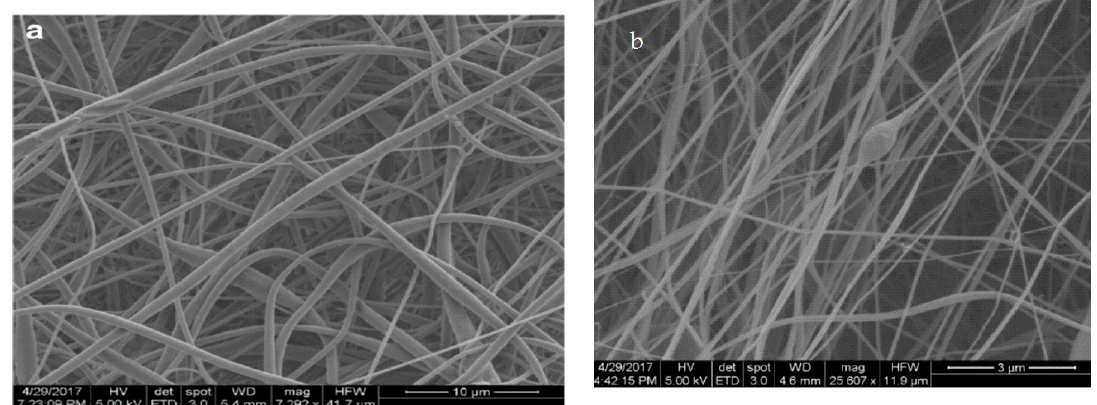
Figure 12. Scanning electron micrographs of electrospun nanofibers with a PVDF concentration of 25% and ( a ) DMF/acetone ratio of 1, and ( b ) DMF/acetone ratio of 3. Reproduced with permission from [124], published by Springer, 2018.